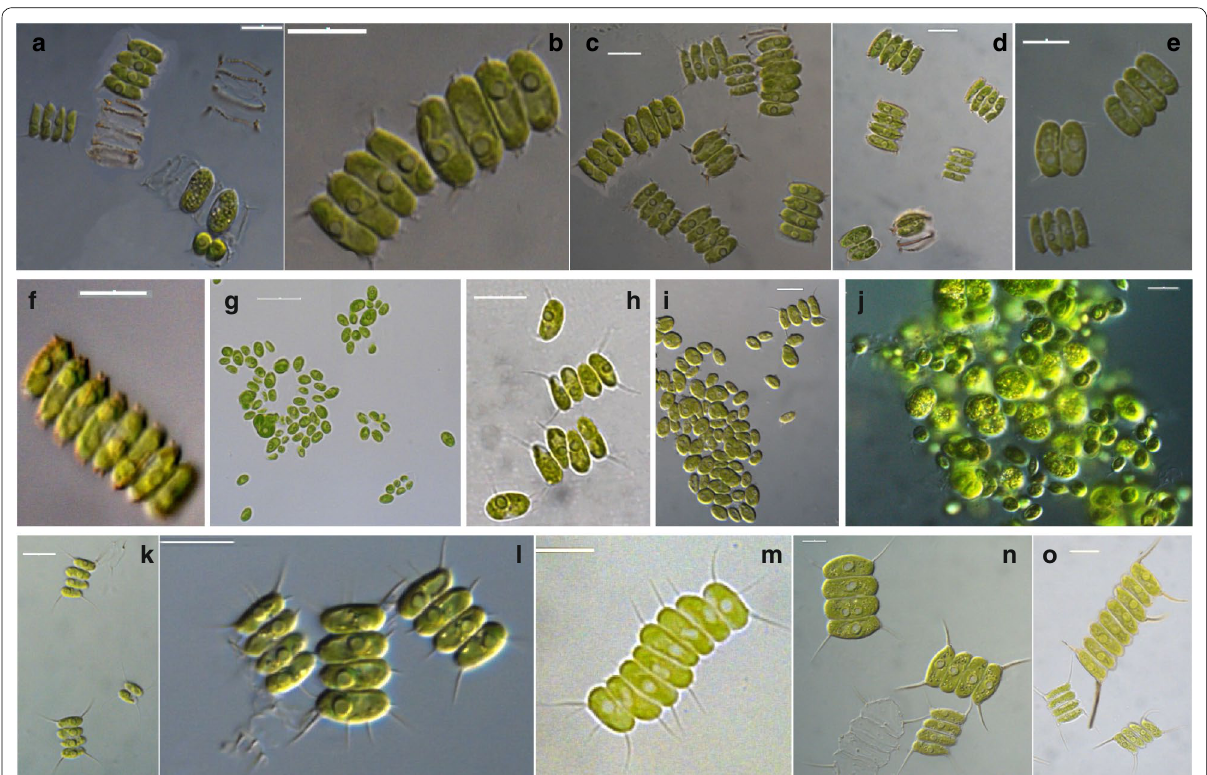
Fig. 1 Microphotographs of strains TAU-MAC 0810, 0910, 1010, 2810, 3410 under light microscopy. a – c Desmodesmus sp. TAU-MAC 0910 and d – f TAU-MAC 1010 demonstrating mature and young coenobia with polar and lateral spines; a , c , d autosporangia, a , d cell wall ornaments observable from cell wall residues, f eight-celled coenobium. g – i Desmodesmus abundans TAU-MAC 0810 and j , k TAU-MAC 3110; coenobia with polar and lateral spines, unicells and aggregation forms. l , m Desmodesmus subspicatus TAU-MAC 2810; coenobia with lots of lateral spines. n , o Desmodesmus communis TAU-MAC 3410. Bars, 10